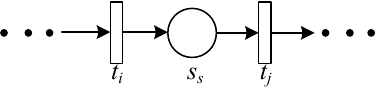
Figure 2. The serial structure.